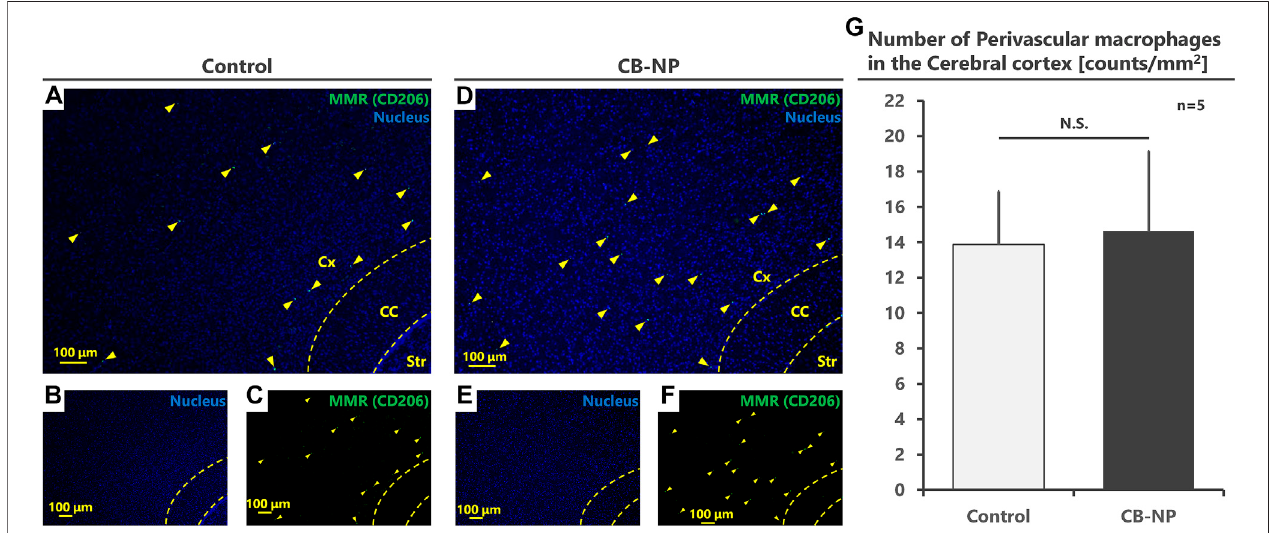
FIGURE 2 | Quanti fi cation of the number of perivascular macrophages (PVMs). The number of PVMs in the cerebral cortex was counted and compared between the control and CB-NP exposure groups. (A – F) Low-magni fi cation images to quantify the number of PVMs using MMR expression. (A,D) are merged pictures of (B,C,E,F) , respectively. Arrowheads indicate MMR-positive PVMs. (G) Number of PVMs in the cerebral cortex. Values are expressed as the mean ± SD. Abbreviation: Carbon black nanoparticle (CB-NP), Cerebral cortex (Cx), Corpus callosum (CC), and Striatum (Str), Standard deviation (SD).